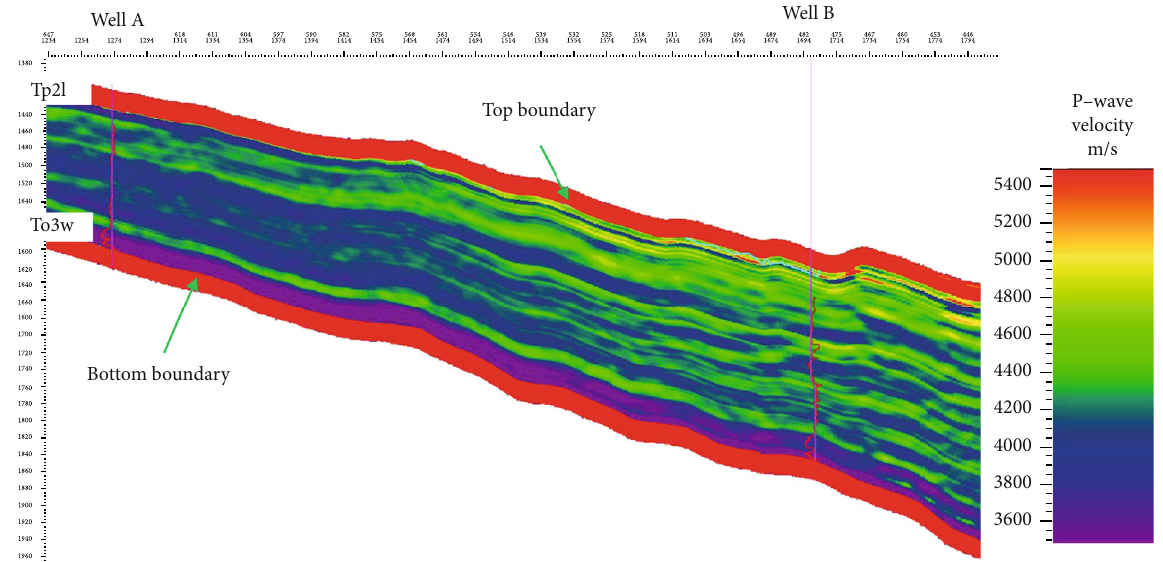
Figure 11: The P-wave velocity pro fi le of the connecting well from well A to well B in the Wufeng- Longmaxi